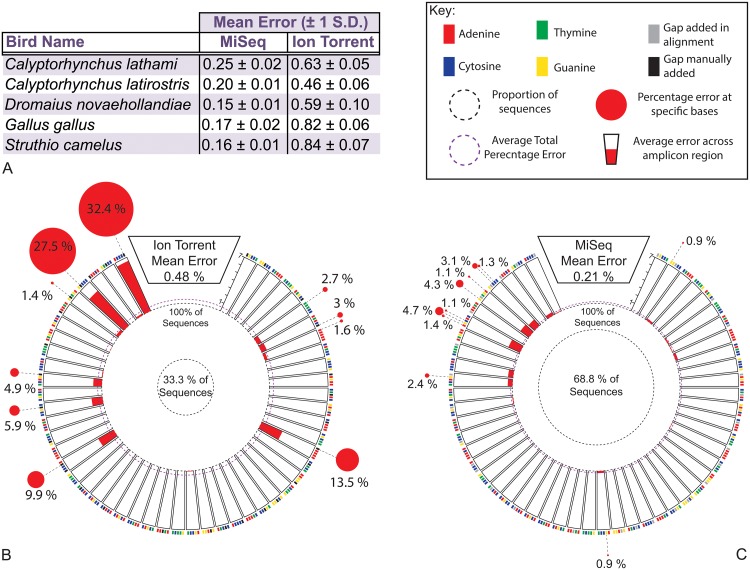
Average sequencing error rates across a single amplicon region.Average sequencing error rates are shown for multiple bird species across the whole of a short 12S rRNA gene region (A). Additionally, the error profile across the gene region is shown for Calyptorhynchus lathami for both the Ion Torrent PGM (B) and MiSeq (C) with key. The error patterns observed were similar across all species sequenced. Error rates are shown across 5 bp segments and where error rates were above 1% for a single base this is indicated through the red circles.